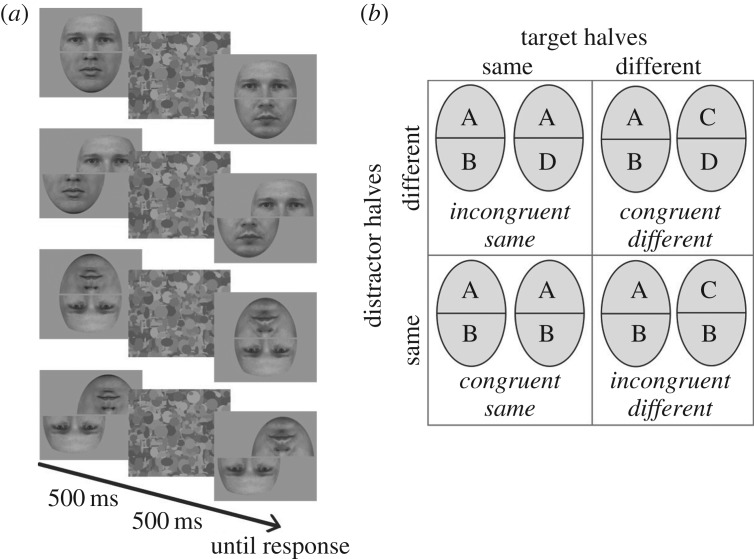
(a) Illustration of each condition; upright aligned, upright misaligned, inverted aligned and inverted misaligned. Each trial began with a central fixation cross. The first target face was then presented for 500 ms, followed by a mask for 500 ms. The second face was visible until a response was registered. Observers responded ‘same’ or ‘different’ using the keyboard. Observers were instructed to make their judgement on the upper face half (i.e. the eye region) irrespective of composite orientation. (b) Trial types for the complete composite design used in Experiment 3.